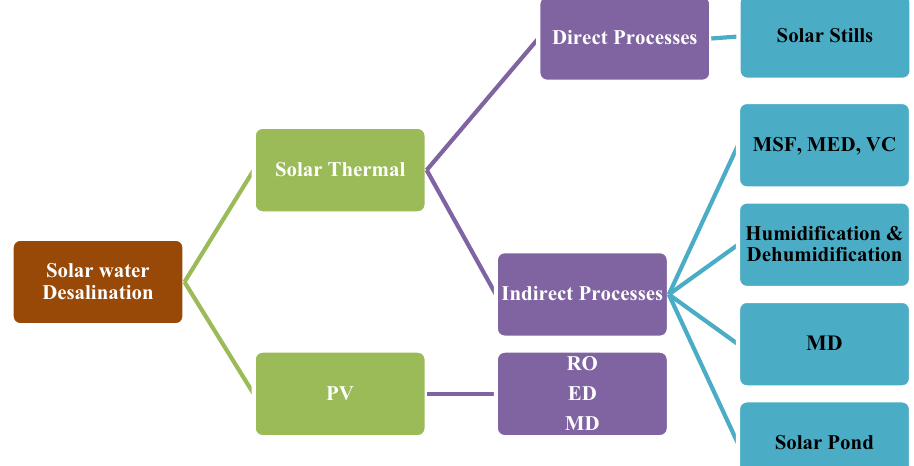
Fig. 25 Different strategies for using solar energy in desalina- tion process (Caldera et al. 2016)